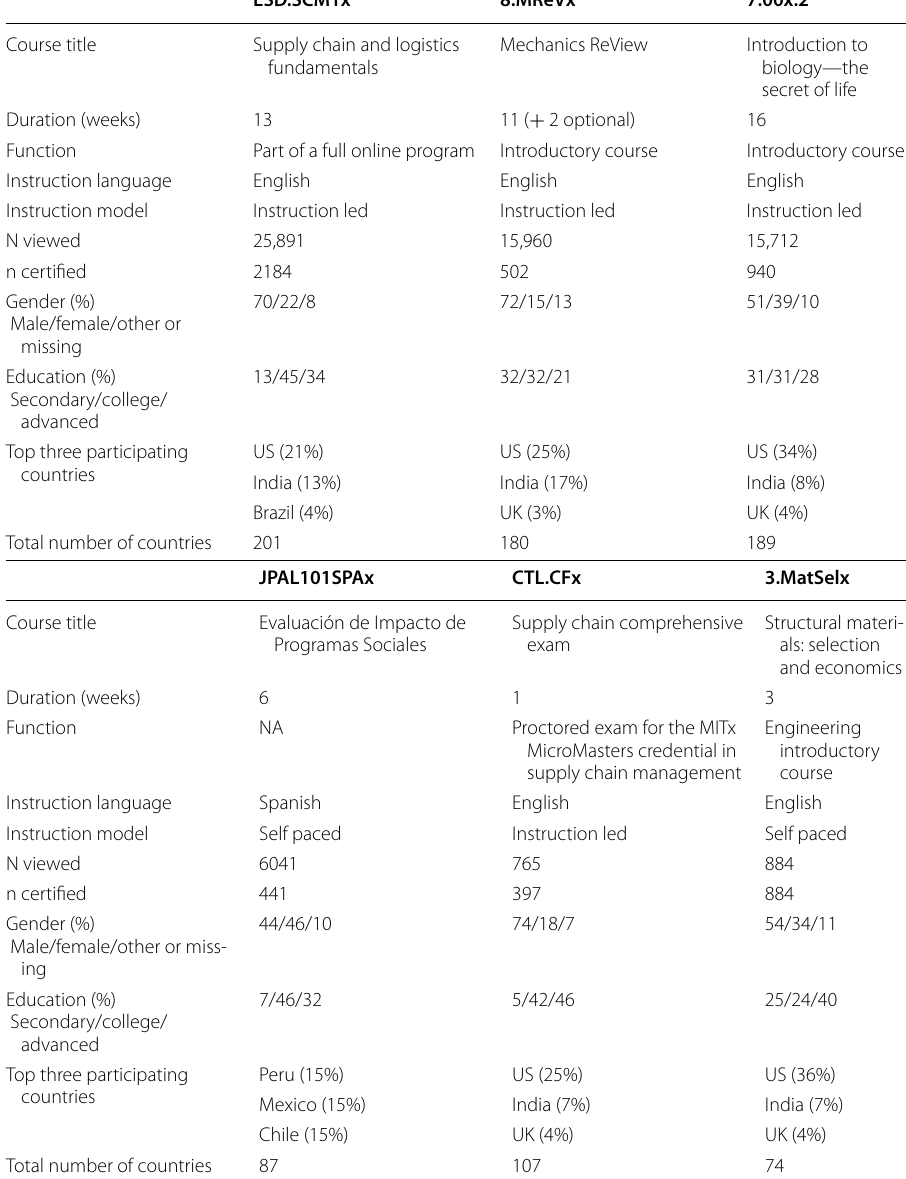
Table 1 RQ4 and RQ5 courses